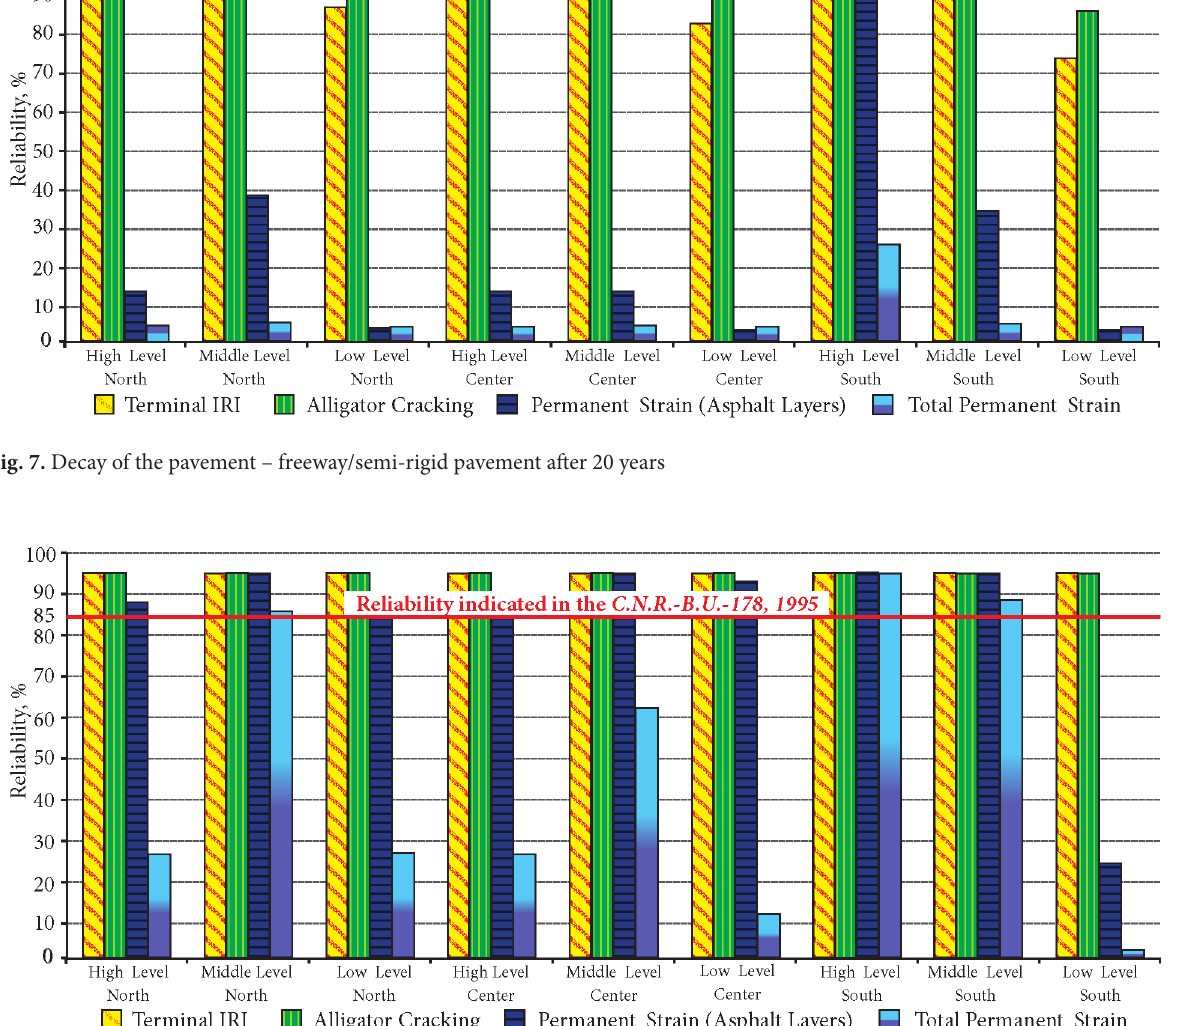
fig. 8. Decay of the pavement – highway/semi-rigid pavement after 20